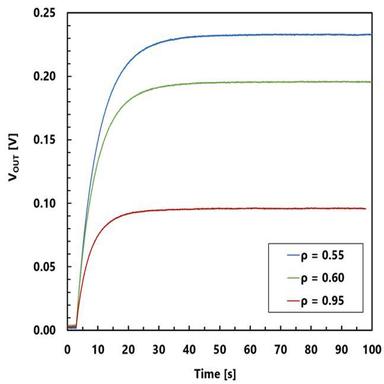
Capacitor charging times - comparison between two porous freeze cast barium titanate samples (blue and green lines) and dense barium titanate (red). Legend indicates density level of the material. (https://doi.org/10.6084/m9.figshare.12585023) (https://doi.org/10.6084/m9.figshare.12585023), CC BY 4.0 license].